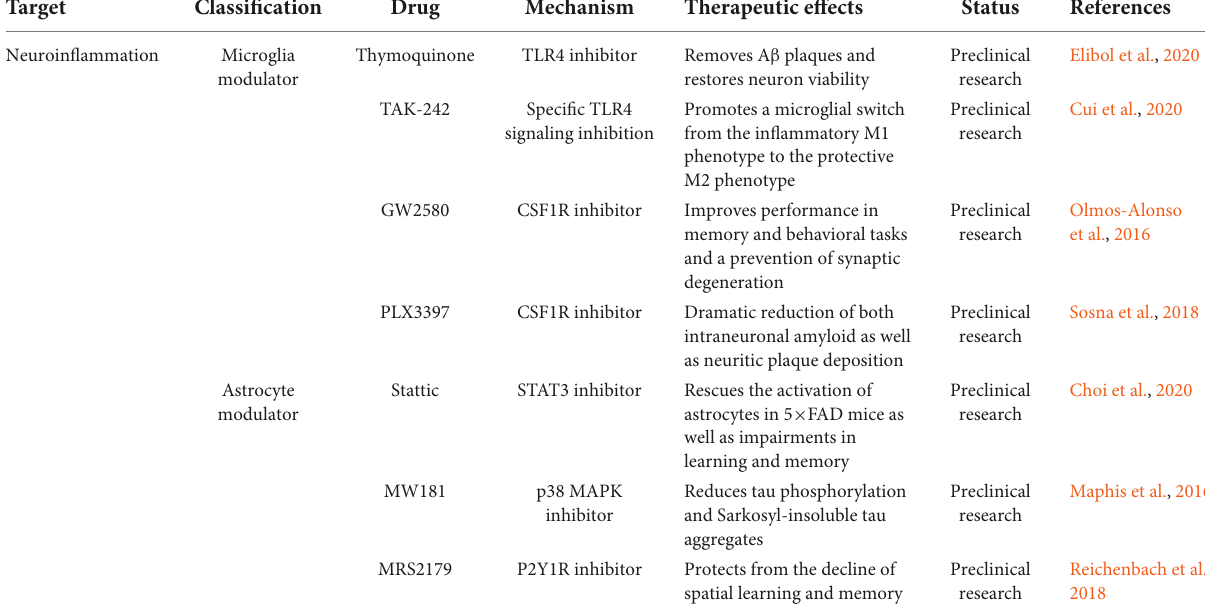
TABLE 3 Alzheimer’s disease (AD) therapeutic strategies targeting